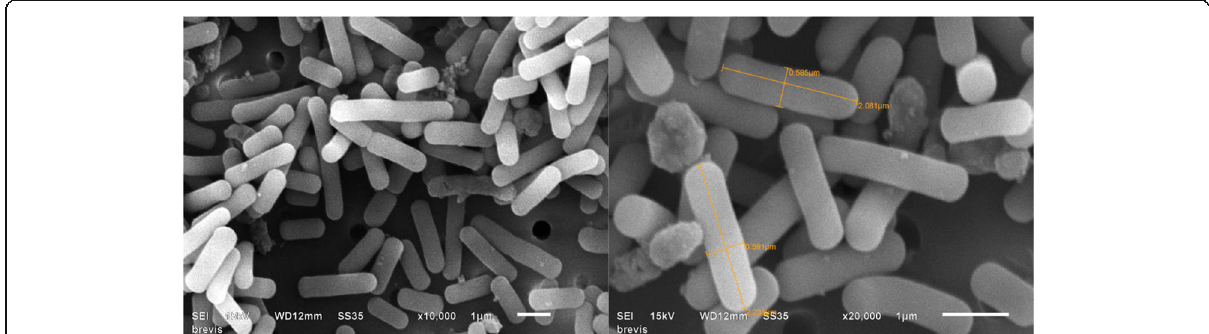
Fig. 3 Scanning electron micrographs of free L. brevis